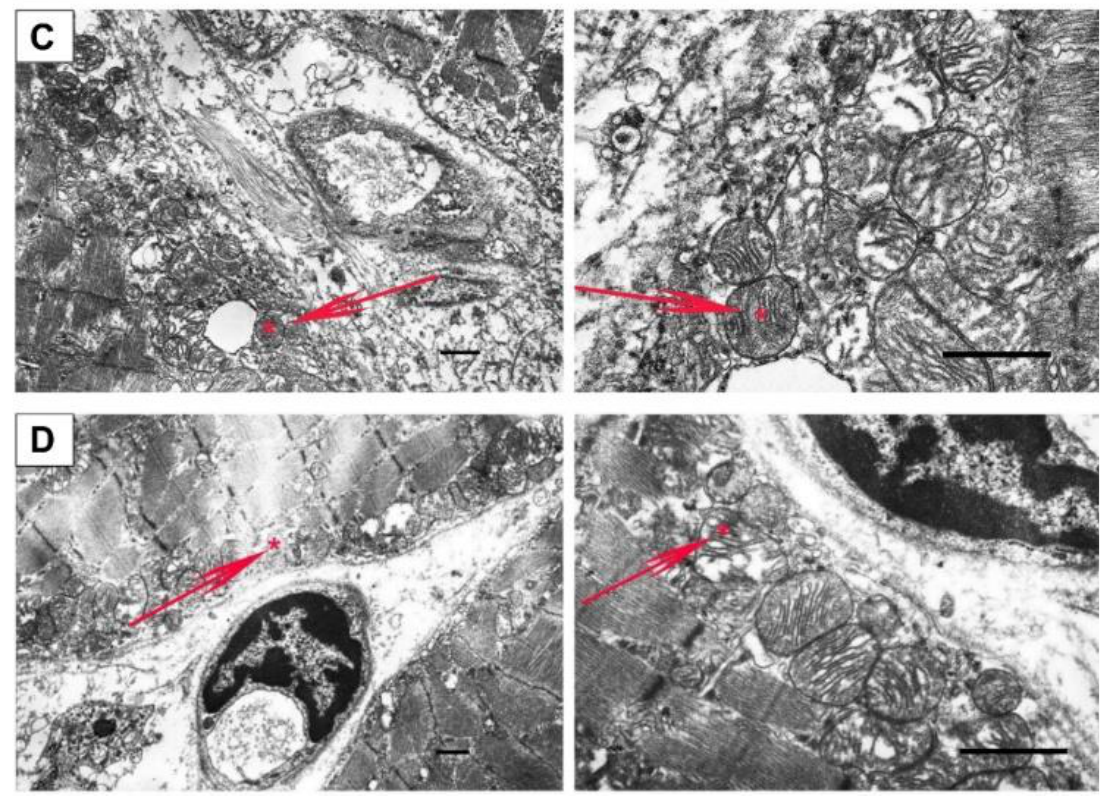
Figure 4. Representative transmission electron micrographs of mouse skeletal muscle (quadriceps) sections from WT ( A ), WT+U ( B ), mdx ( C ), and mdx +U ( D ) groups showing the quality of the ultrastructure of the subsarcolemmal population of mitochondria (highlighted by red arrows). An asterisk marks the same mitochondria at low and high magnification. The bars are equal to 1 μm.